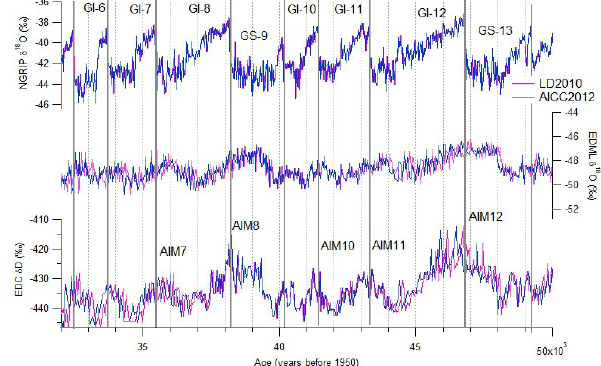
Fig. 4. Water isotopic records of NGRIP (top), EDML (middle), and EDC (bottom), over GI-5 to 12 on the LD2010 timescale in pink, versus the new AICC2012 chronology using additional constraints (this study) in blue. For comparison on the timing of events, the black vertical lines mark the major GS/GI transitions in the NGRIP